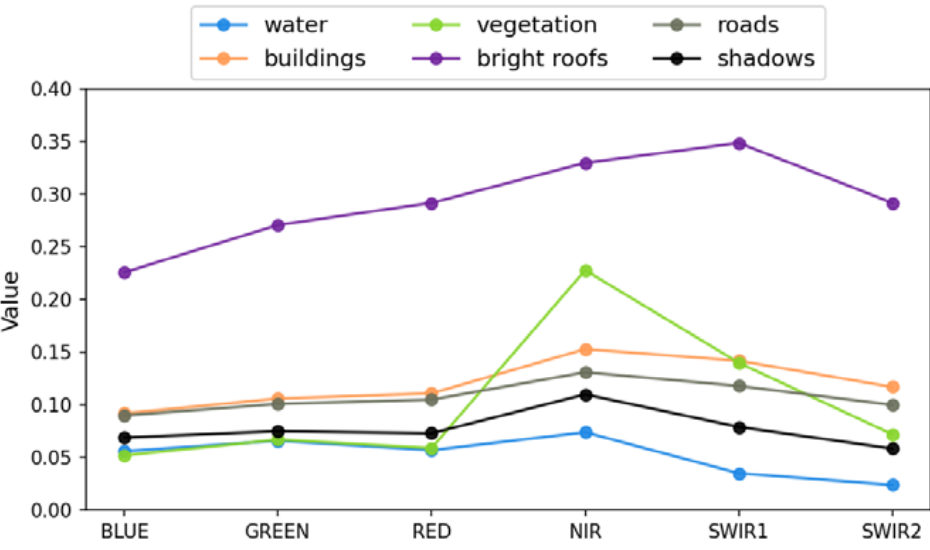
Figure 2. Spectral reflectance curves of six land cover types.